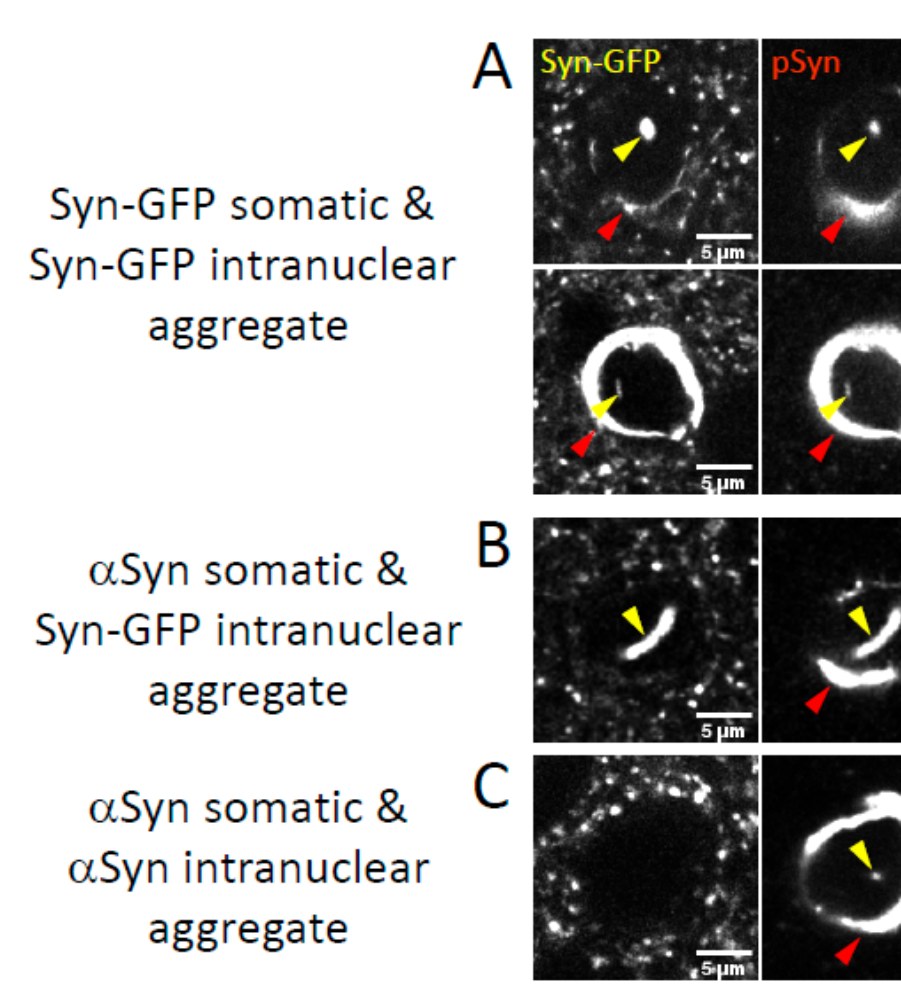
Figure 2. Intranuclear aggregates form in neurons bearing somatic Lewy pathology after PFF injection. Confocal imaging in fixed tissue from PFF-injected Syn-GFP transgenic animals induced to form Lewy pathology shows examples of inclusions where both the somatic (red arrowheads) and intranuclear (yellow arrowheads) aggregates are Syn-GFP positive ( A ), where the somatic inclusion is made up of endogenous mouse alpha-synuclein (not transgenic Syn-GFP), but the intranuclear aggregate is Syn-GFP positive ( B ), and where both the somatic and intranuclear aggregates are made up of endogenous mouse alpha-synuclein ( C ). All aggregates are also stained for the marker of alpha-synuclein aggregation serine-129 phosphorylation (pSyn). Scale bar: 5 μ m.